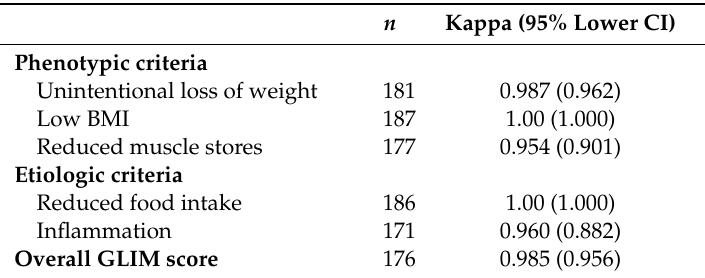
Table 6. Inter-rater reliability.